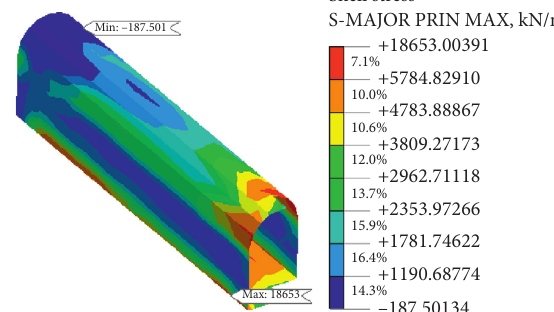
Table 1: Material parameters of the model.